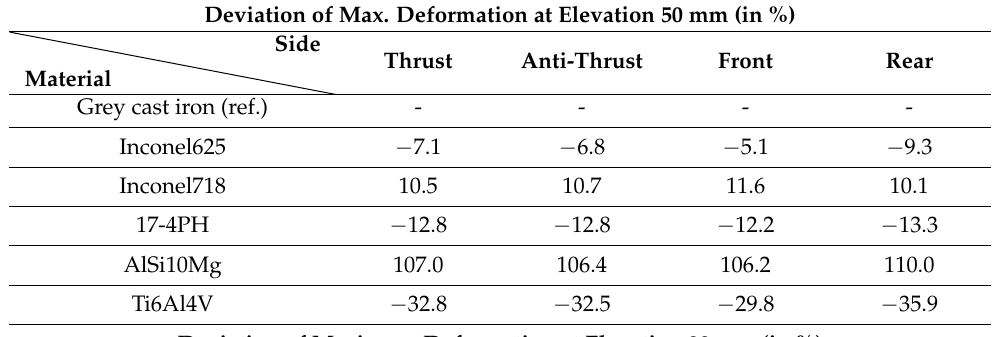
Side Thrust Anti-Thrust